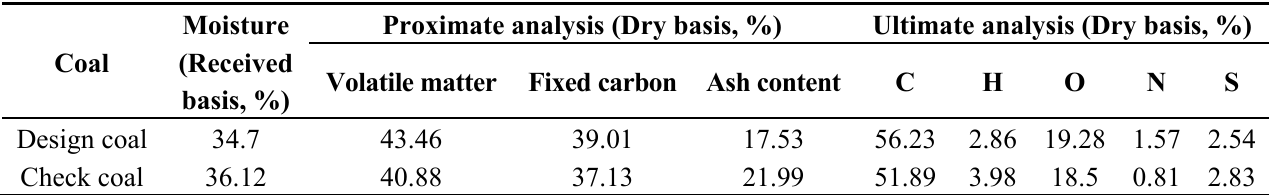
Table 2. The chemical composition of